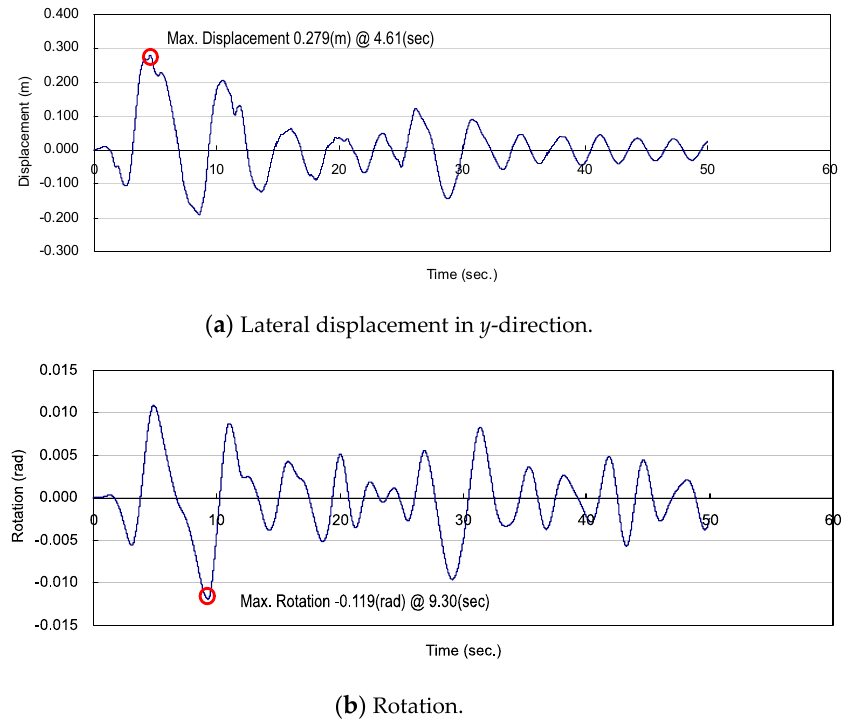
Figure 16. Lateral displacement and rotation history estimated at the center of mass (El Centro, α = 1.3, β = 1.0).